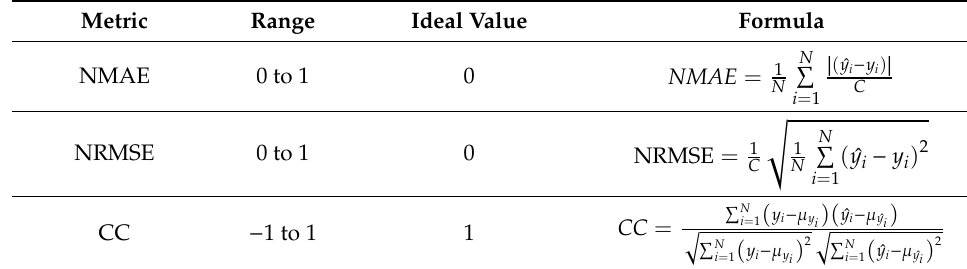
Table 3. Evaluation metrics selected to assess the accuracy of PV power forecast results. Data ranges and ideal values are given for each metric.